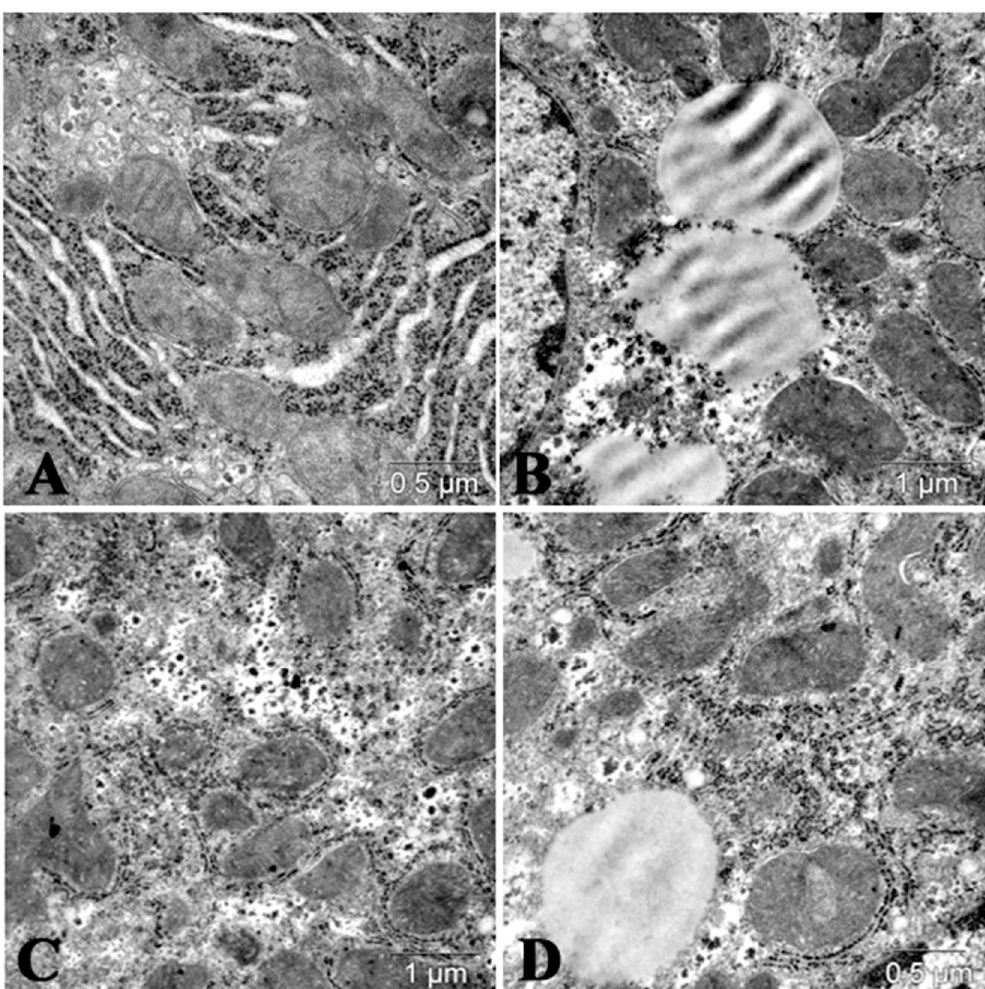
Figure 6. Hypolipidemic effects of mannan Serotype A and mannan Serotype B ( C. albicans ) in mice with lipemia induced by P-407. ( A ) Liver of control mice; ( B ) 24 h after P-407 administration in mice. Lipid droplets in cytoplasm of hepatocytes; ( C ) significantly decreased number of lipid droplets in liver cells of mice with lipemia induced by P-407 (24 h), pretreated by mannan A; and ( D ) moderate number of lipid droplets in liver of mice with P-407-induced lipidemia pretreated by mannan B.